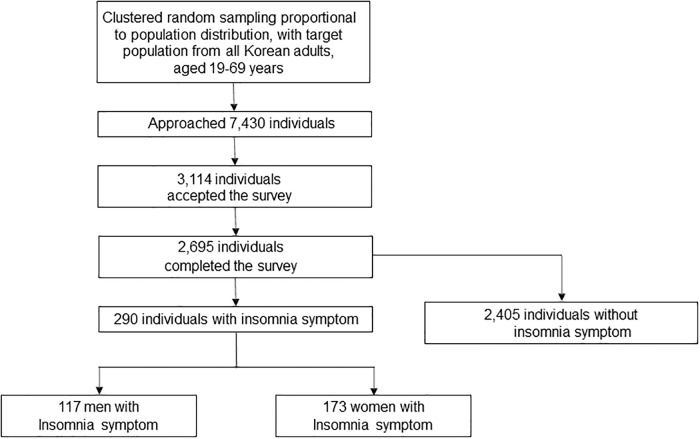
Flow chart depicting the participation of subjects in the Korean headache-sleep study.